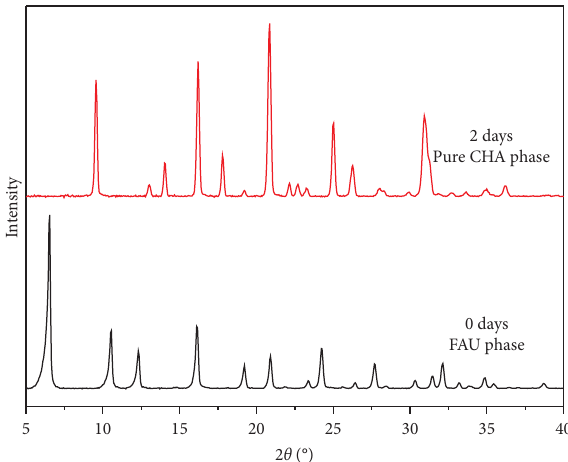
Figure 2: X-ray diffraction patterns of faujasite (0-day crystalli- zation) and CHA (2-day crystallization) using CBV100 as Al source and DMECHA as the OSDA. Pure CHA phase obtained after 2 days indicated complete transformation of FAU